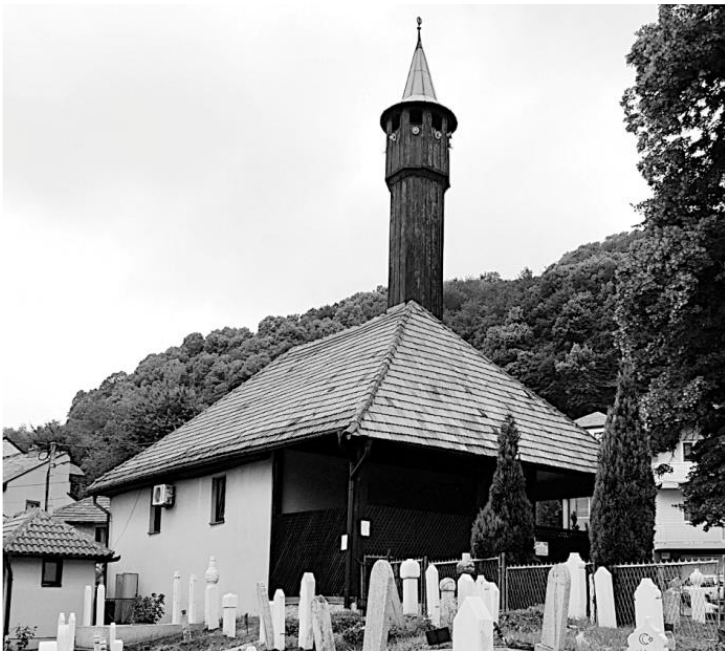
Figure 4. Osman Ćehaja Mosque in Tuzla before the renovation (Photo by the author)